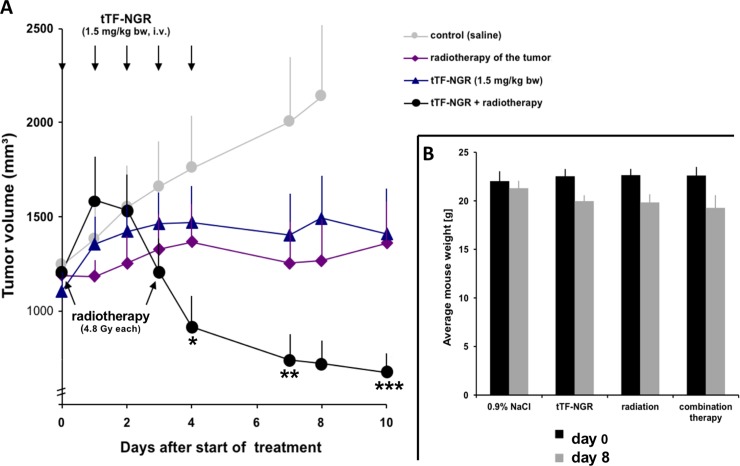
HT1080 human sarcoma xenograft growth in CD-1 athymic mice and body weight comparison under therapy with intravenous (i.v.) tTF-NGR, tumor radiotherapy, and a combination of both therapeutic modalities, respectively.(A) Arrows show treatment intervention for tTF-NGR (1.5 mg/kg body weight (bw) x 5) or tumor radiotherapy (4.8 Gy x 2). Control group (0.9% NaCl (= saline) i.v. at identical days as tTF-NGR, n = 6) is represented by grey dots, tTF-NGR group (n = 5) by blue triangles, radiotherapy (n = 8) by red diamonds, and combination (n = 6) by black dots. Given are mean values plus standard error (SE) bars. *, first day of significant tumor size difference between combination therapy and control (Mann-Whitney rank sum test, two sided p value <0.05); **, significant tumor size difference between tTF-NGR monotherapy and combination (two sided p value <0.05); ***, significant tumor size difference between irradiation monotherapy and combination therapy (two sided p value <0.05). (B) Body weight (b.w.) comparison of the mice at the beginning and at the end of the observation (day 8). Given are mean values (g, gram) with standard error (SE) bars. Dark grey columns represent b.w. before start of experiment, light grey columns represent b.w. at the end of observation (day 8). Statistical comparison (t-test) revealed b.w. decrease, when values before treatment and at day 8 were compared: two-tailed p-values for 0.9% NaCl control (p = 0.1449), tTF-NGR (p = 0.0211), radiation (p = 0.0006), combination treatment (p = 0.015), with significant decrease for all groups except the controls. When the b.w. values at day 8 were compared between the different groups there were no significant differences (all two-tailed p-values > 0.2) indicating no significantly lower b.w. in any group as compared to any other.